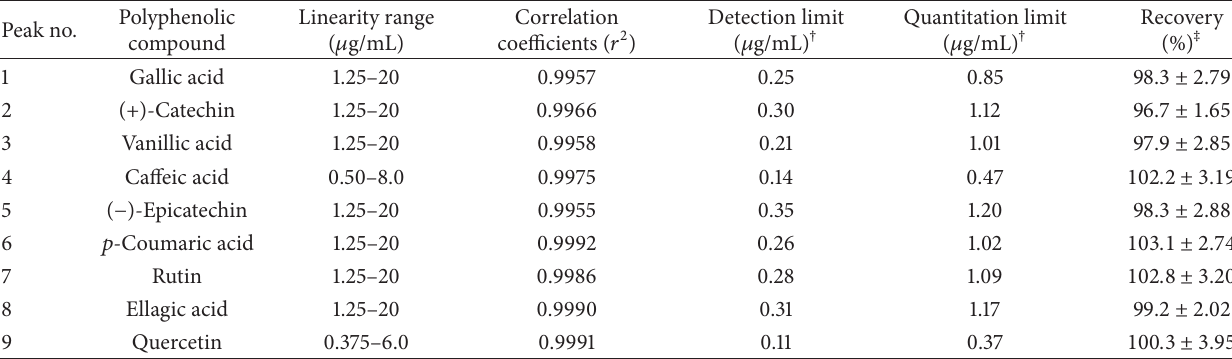
Table 2: Parameters of calibration graphs for the nine phenolic standards used.